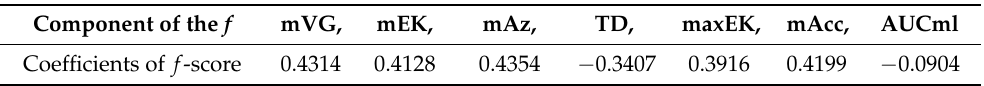
Table 3. Coefficients of the f -score in relation to the component of the f -vector. Details of the parameters used are in Section 2.3.